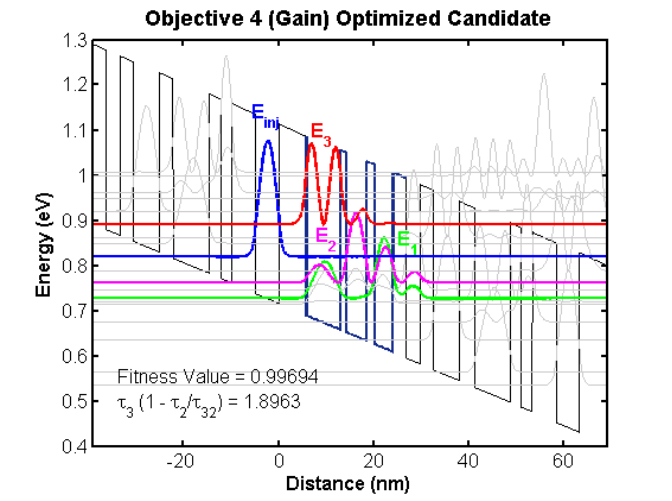
Figure 11. objective (4) fitness rank given a training initial